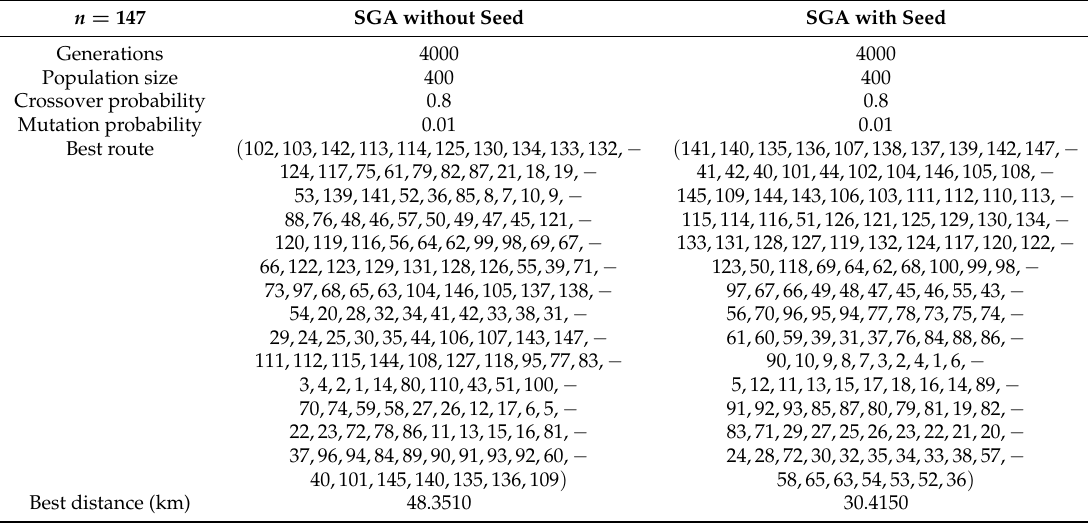
Table 8. Results of the n = 147 problem.